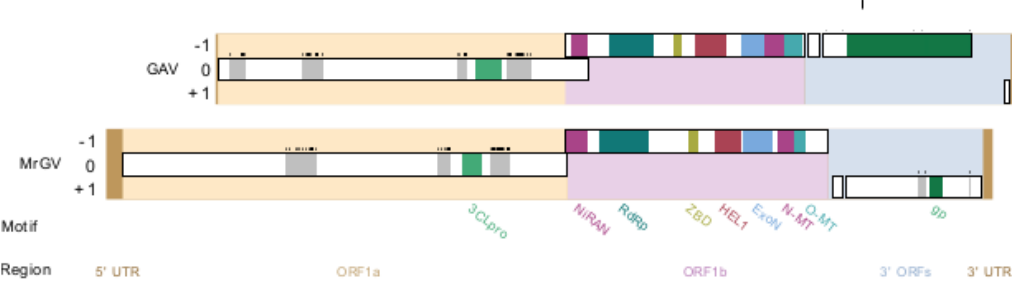
Figure 3. Schematic illustration of linear Macrobrachium rosenbergii Golda Virus (MrGV) and gill-associated virus (GAV) genomes and proteomes. Open reading frame (ORF) 1a is set as reading frame zero and genomes are spit into five sections: 5 (cid:48) untranslated region (UTR), ORF1a, ORF1b, 3 (cid:48) ORFs and 3 (cid:48) UTR. Transmembrane (TM) regions are shown in grey with predicted TM helices shown as black bars above these regions. Predicted protein motifs are a 3C-like protease (3CLpro), nidovirus RdRp-associated nucleotidyltransferase (NiRAN), RNA-dependentRNA polymerase (RdRp),zinc-bindingdomain(ZBD),superfamily 1 helicase (HEL1), 3 (cid:48) -5 (cid:48) exoribonuclease (ExoN), S-adenosylmethionine (SAM)-dependent N7- and 2 (cid:48)